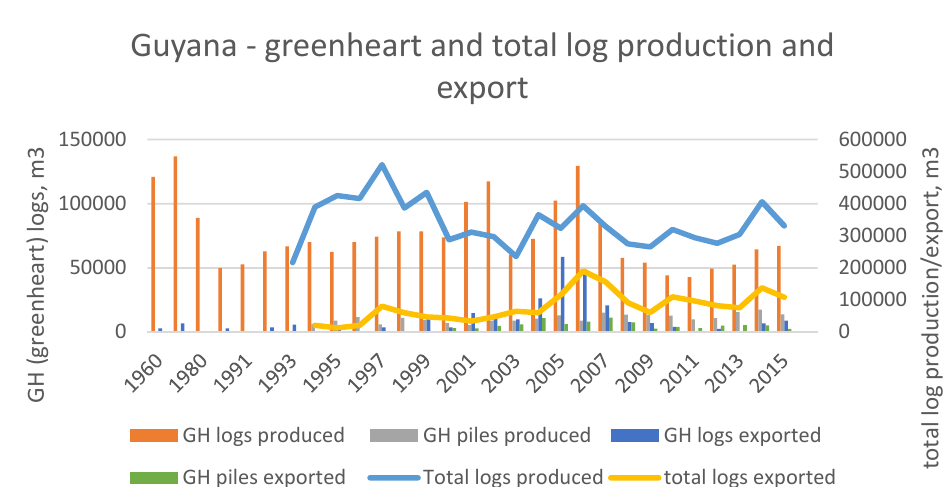
Figure 2. Guyana—greenheart and total log production and export.